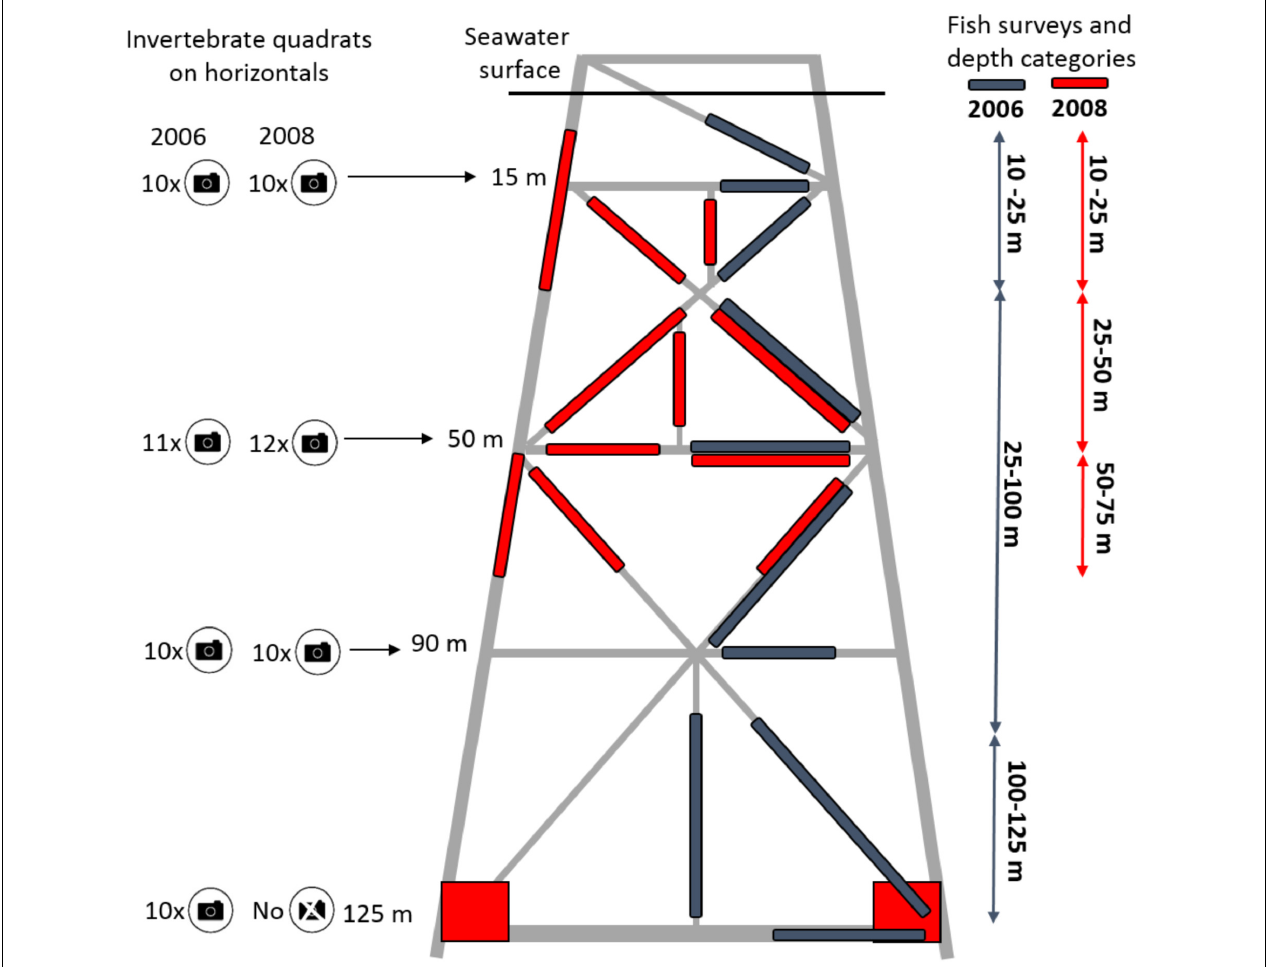
FIGURE 1 | Schematic diagram of Goodwyn Alpha (GWA) platform showing its structure including the horizontal, vertical, and diagonal cross beams surveyed for marine life. Horizontal beams or members at 15, 50, 90, and 125 m were surveyed for attached sessile invertebrates in 2006 and 2008, with the exception of the 125 m depth in 2008 when footage was not available. Fish transects are shown as blue (2006) and red bars (2008). Red squares indicate the location of fish counts from stationary images conducted at the base of the structure during 2008. Vertical arrows indicate the depth zones used for analysis in each year. The number associated with the camera icon indicates the number of quadrats per horizontal member used in the invertebrate surveys in each year. Drawing not to